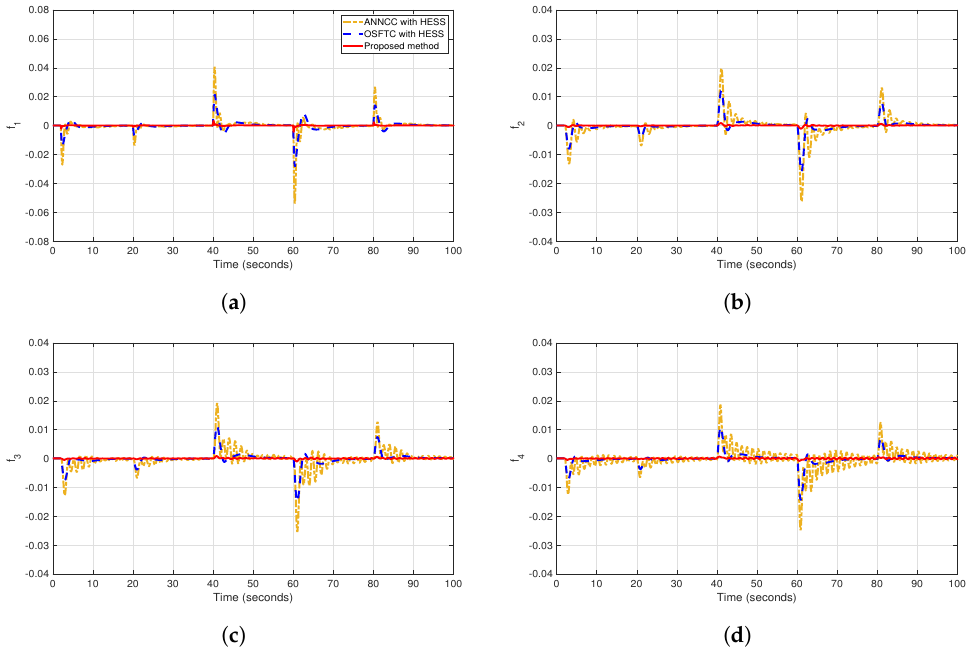
Figure 8. The f i of a four-area MIPS under the load disturbances shown in Figure 5: ( a ) ∆ f 1 ; ( b ) ∆ f 2 ; ( c ) ∆ f 3 ; and ( d ) ∆ f 4 .